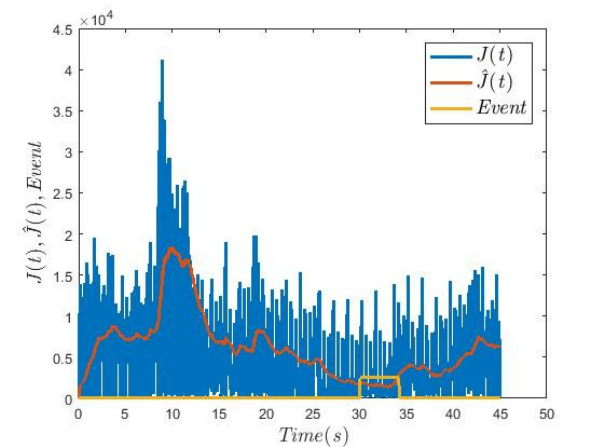
Figure 5. EEG signal in one of the channels, filtered by a Butterworth filter of the 8th order and notch filters